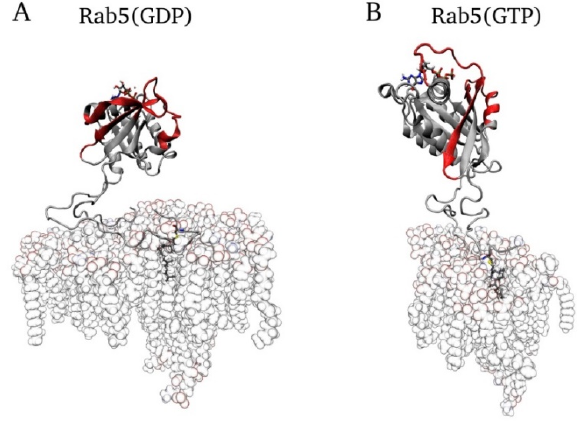
Figure 7. Final conformations of A ) mono-GG Rab5(GDP) and B ) mono-GG Rab5(GTP) in the physiological early endosomal six-component membrane.